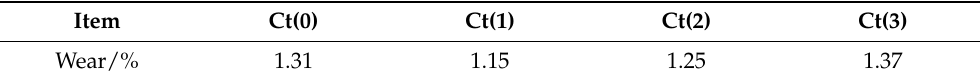
Table 7. Abrasion test results of molded titanium-containing mesoporous silica